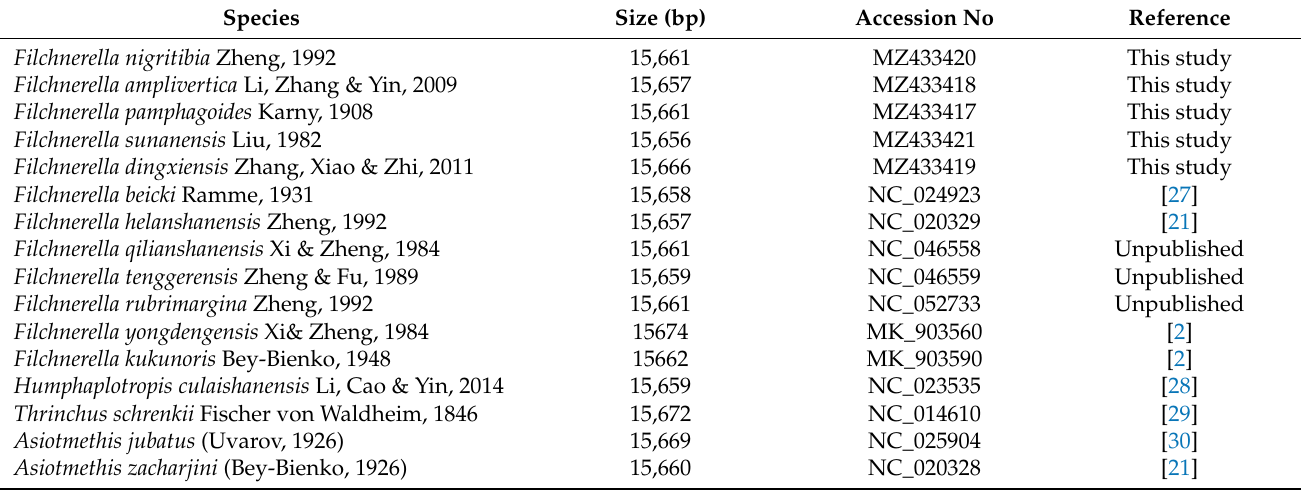
Table 2. Summary of mitogenomes used in this